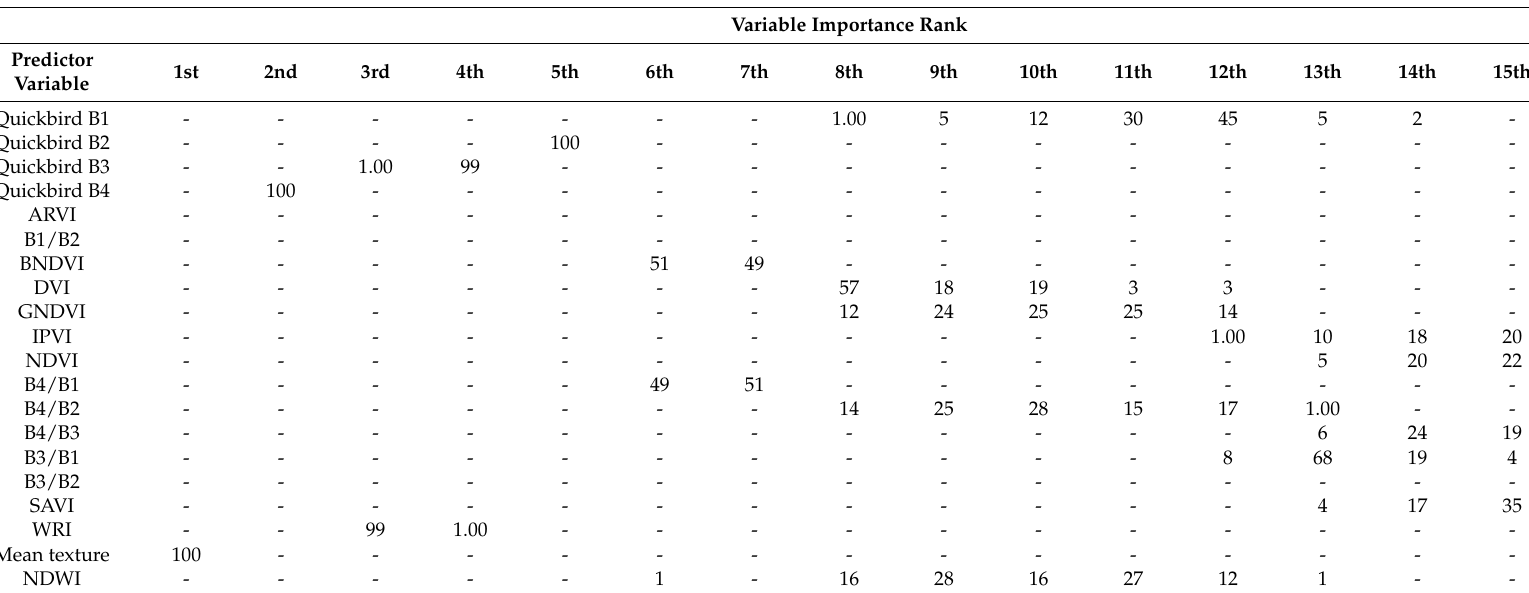
Table 6. The importance of each predictor variable (based on MDG) for both pixel-based RF classification approaches (cumulative count of importance out of 100 iterations; only the top 20 important variables are included). Abbreviations are found within the text and Table